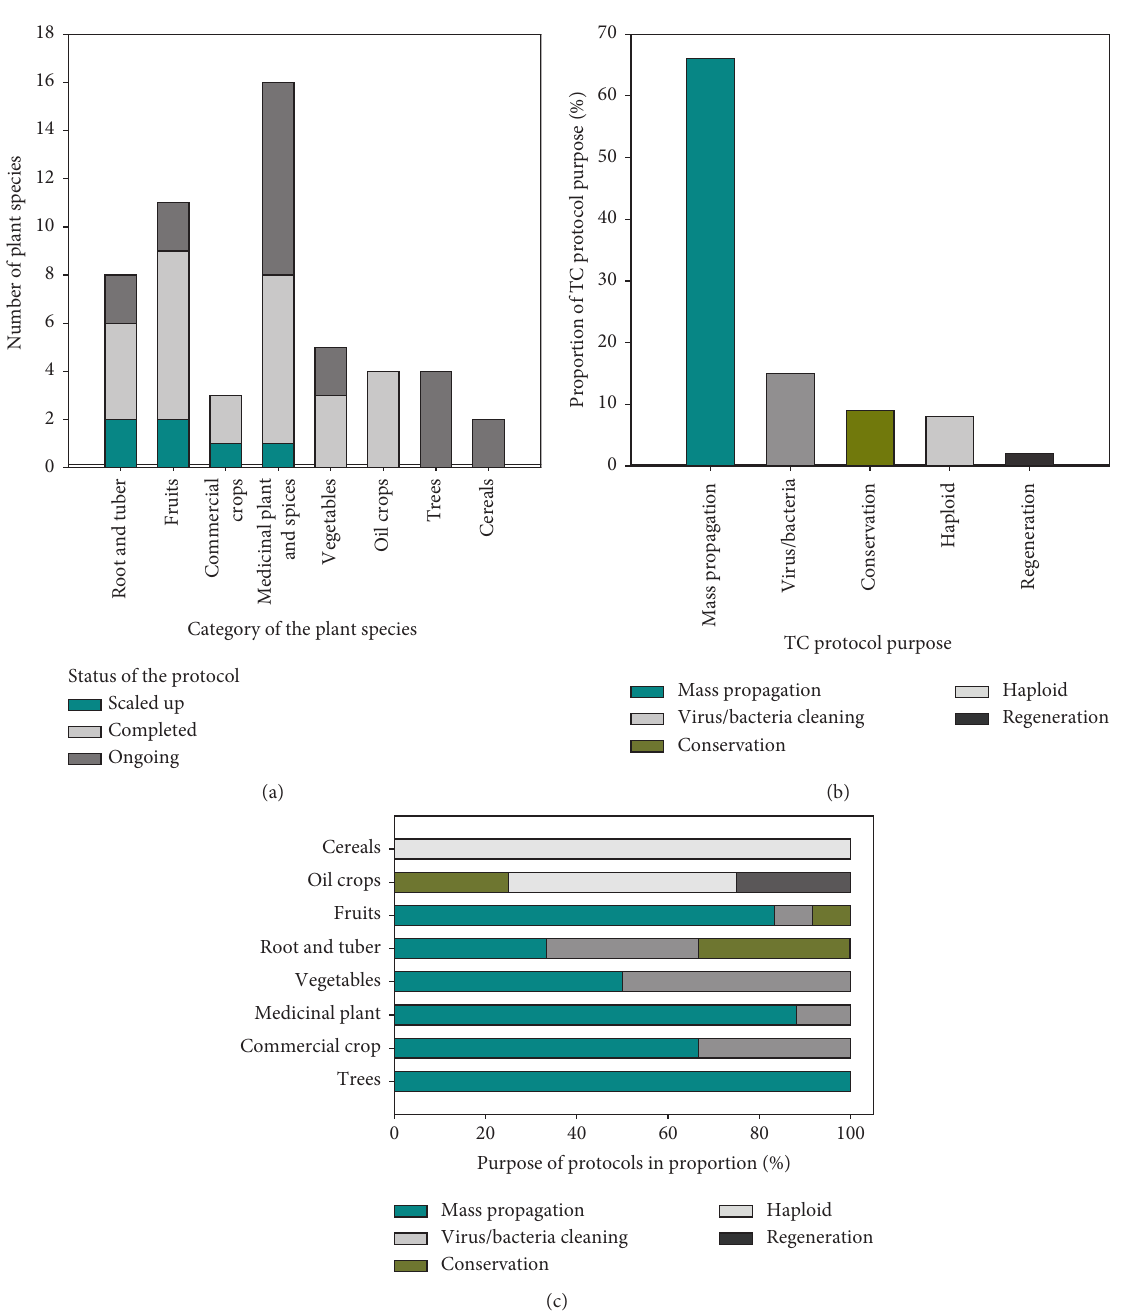
Figure 3: Status and purpose of plant tissue culture protocol developed and/or optimized in Ethiopian TC laboratories. (a) The number of plant species that have been under TC protocol optimization/development process, (b) proportion of the purpose of PTC protocols optimized/developed in the assessed laboratories, and (c) proportion of the purpose of PTC protocol in each plant